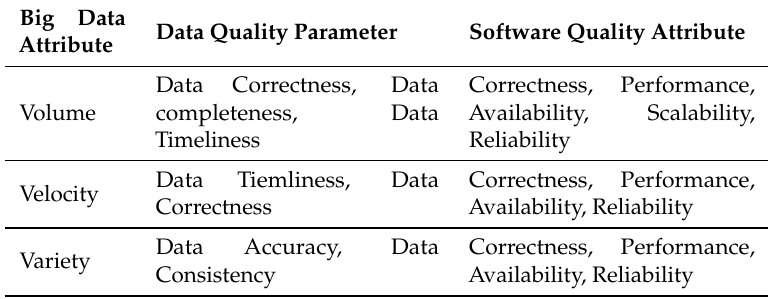
Table 9. Relations among big data attributes, data quality parameters and software quality attributes.